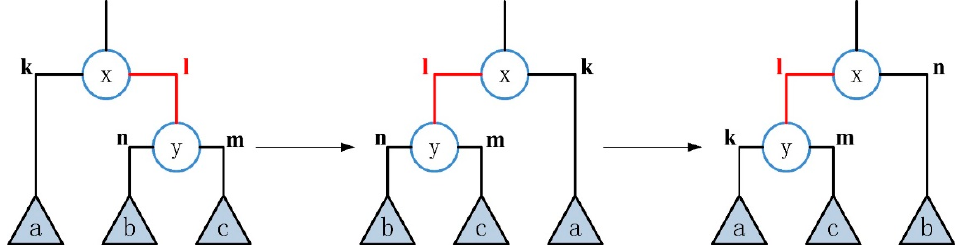
Figure 5. The 𝛼 transformation of the inner edge of type Figure 5. The α transformation of the inner edge of